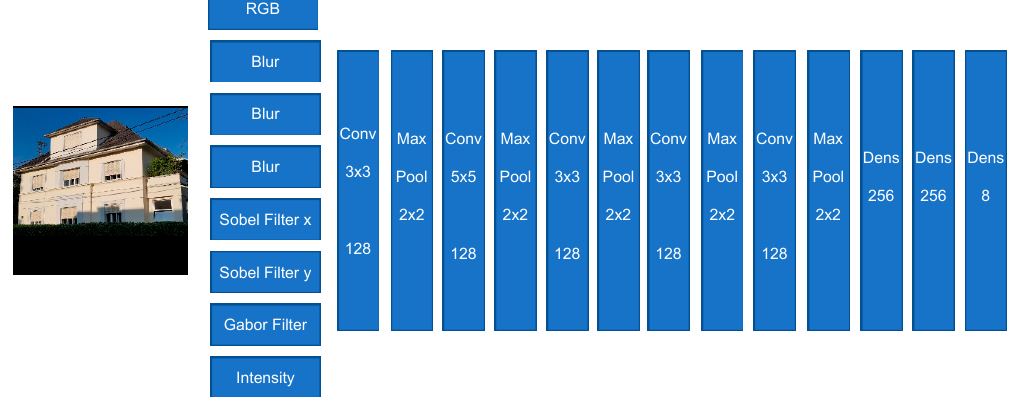
Figure 15. Modell III—Convolutional neural network for house classification. The output of the model consists of 8 house classes (Source of input image: our own image).